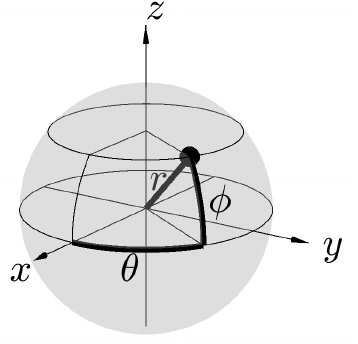
Figure 1. Spherical coordinate